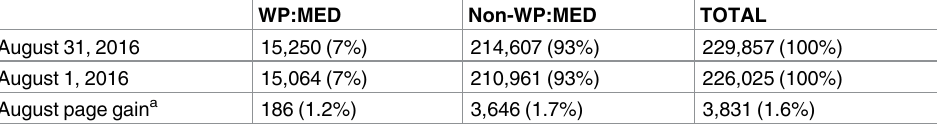
Table 4. Increasesin total Wikipedia pages with one or more DOI citations for WP:MED and non-WP: MED during August